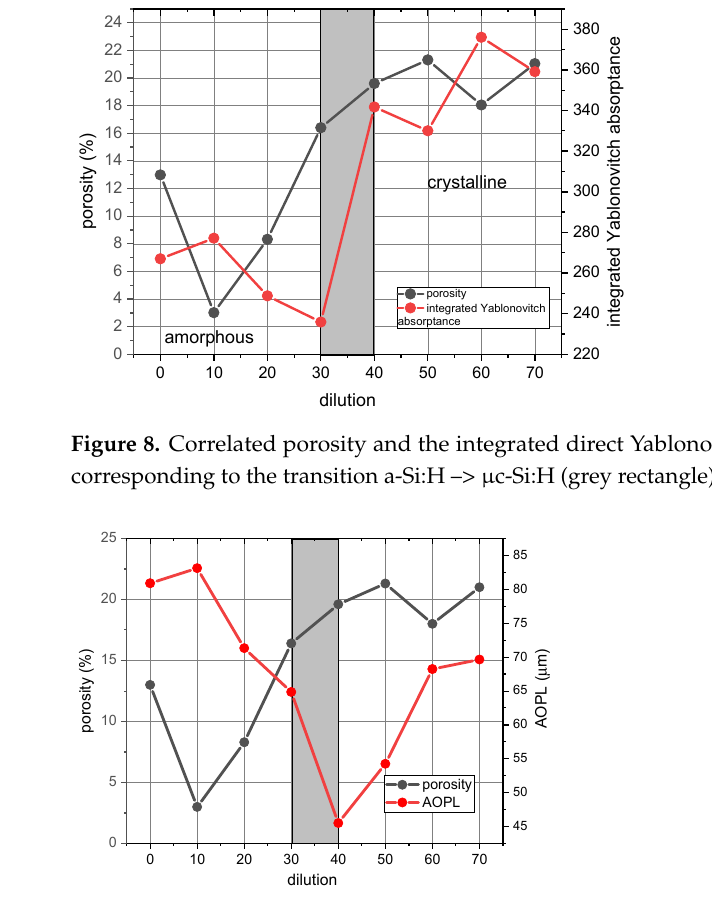
Figure 9. Reverse correlation of porosity and AOPL at the dilutions corresponding to the transition a-Si:H –> μ c-Si:H (grey rectangle) and below this region.